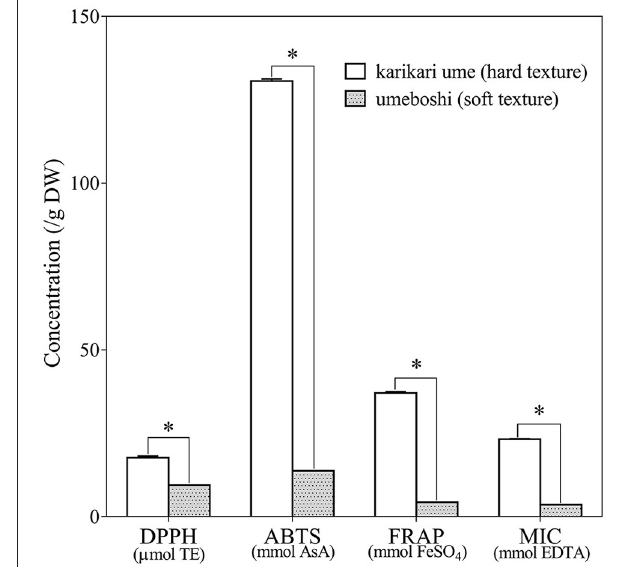
FIGURE 3 | Antioxidant activities assessed by DPPH, ABTS, FRAP, and MIC in Karikari-ume (hard texture) and Umeboshi (soft texture) by microtiter plate assay, * p < 0.05 ( n =